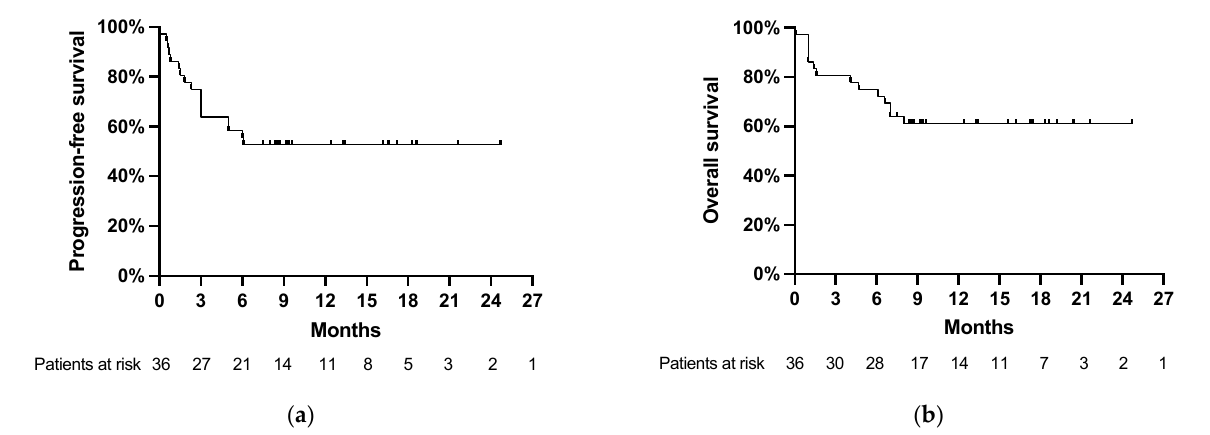
Figure 1. ( a ) Progression ‐ free survival and ( b ) overall survival after CAR ‐ T ‐ cell treatment in the total cohort. Starting time of PFS and OS is on the day of CAR ‐ T infusion (day 0). The last follow ‐ up and data cutoff were on February 1, 2021. Ten out of the seventeen patients with DLBCL relapses following CAR ‐ T ‐ cell infu ‐